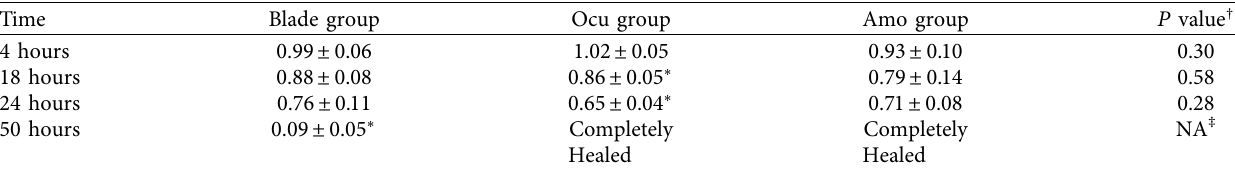
Completely NA ‡ Healed Healed ∗ Statistically significant difference in the epithelial defect area between immediately after epithelial removal and at each time point. † Kruskal–Wallis test. ‡ P value could not be obtained due to the complete healing of the epithelial defect in the Ocu and Amo